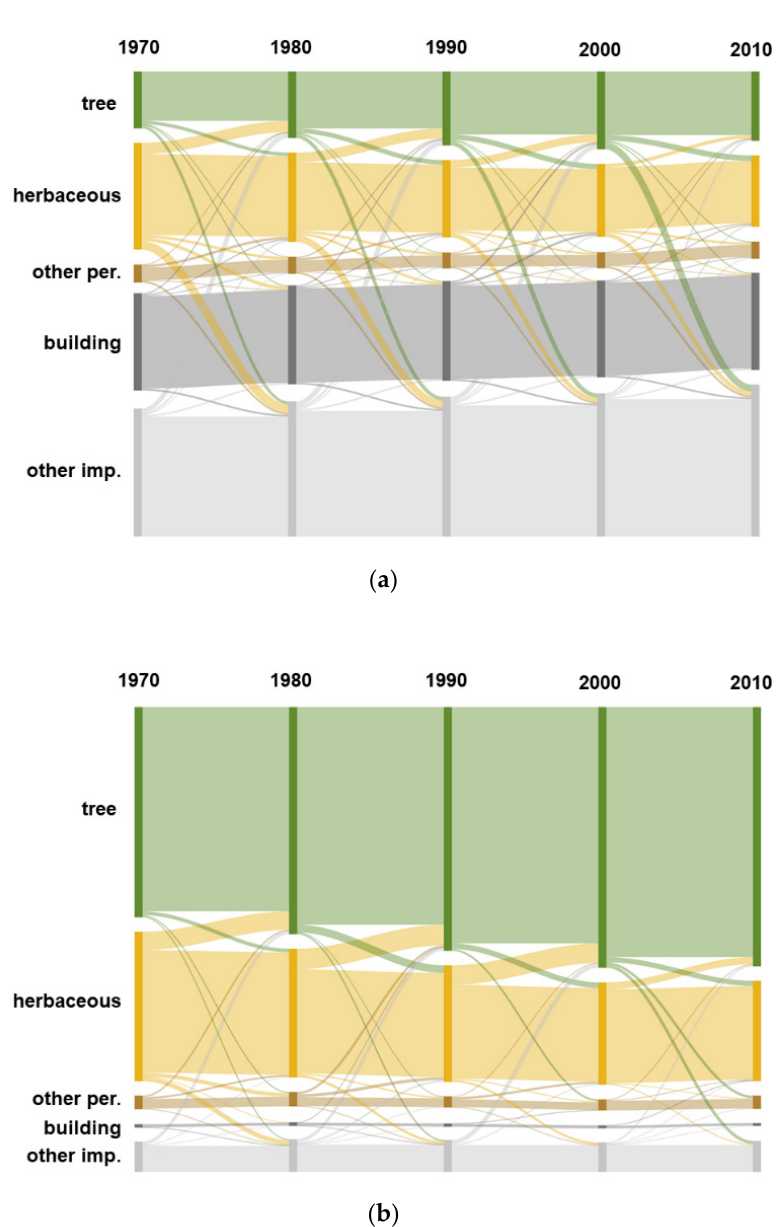
Figure 2. Sankey diagrams depicting transitions across land cover classes for ( a ) developed lands and ( b ) protected open space in Philadelphia. Total land cover in each year adds to 100%, and the thickness of the curves between decades indicates what portion of points transitioned from one land cover class to another over a given decade.